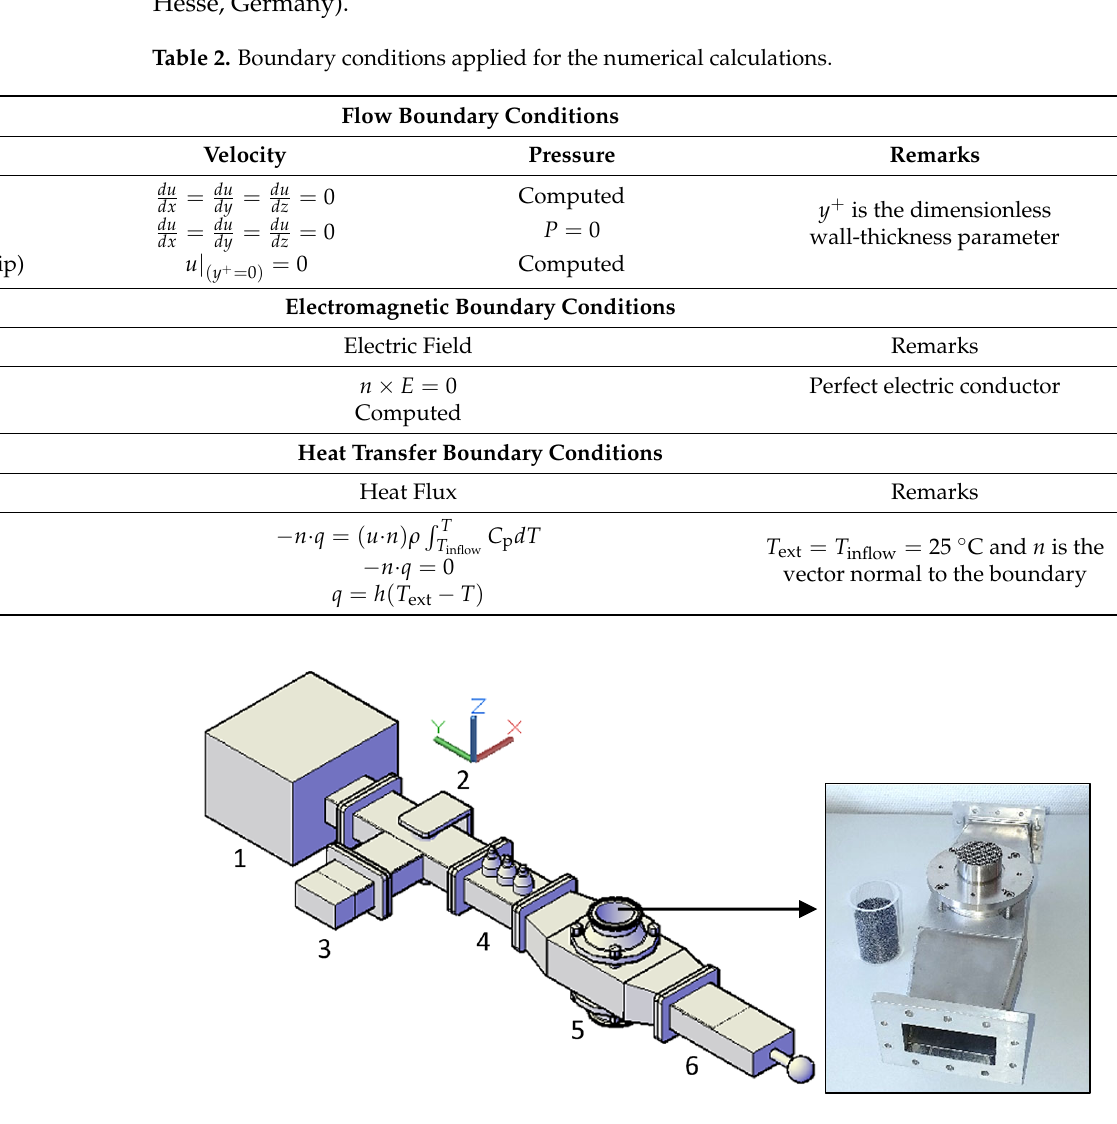
Figure 4. Configuration of the microwave applicator setup: (1) magnetron, (2) isolator, (3) water dummy load, (4) 3 ‐ stub tuner, (5) microwave applicator, (6) sliding short circuit. The microwave applicator is shown on the right with SiSiC ceramic foam sample and quartz tube.